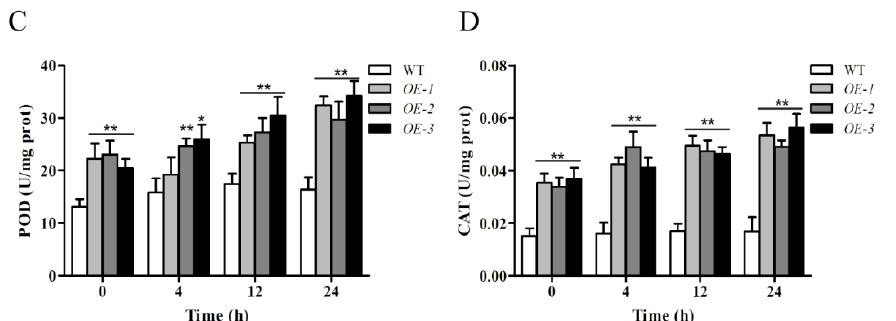
Figure 8. ( A ) The reactive oxygen species (ROS) content and the activities of ( B ) superoxide dismutase (SOD), ( C ) peroxide dismutase (POD), and ( D ) catalase (CAT) under different conditions at different time points (0, 4, 12, and 24 h). Values are means ± SDs of three replicates, and asterisks (* or **) represent the significant differences at p < 0.05 or p < 0.01, respectively (Student’s t -test).